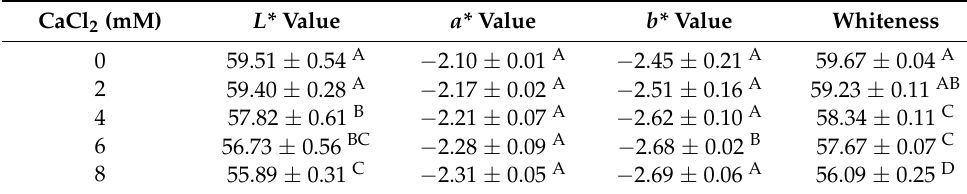
Table 5. Color of the freshly prepared filled hydrogels containing different CaCl 2 levels.